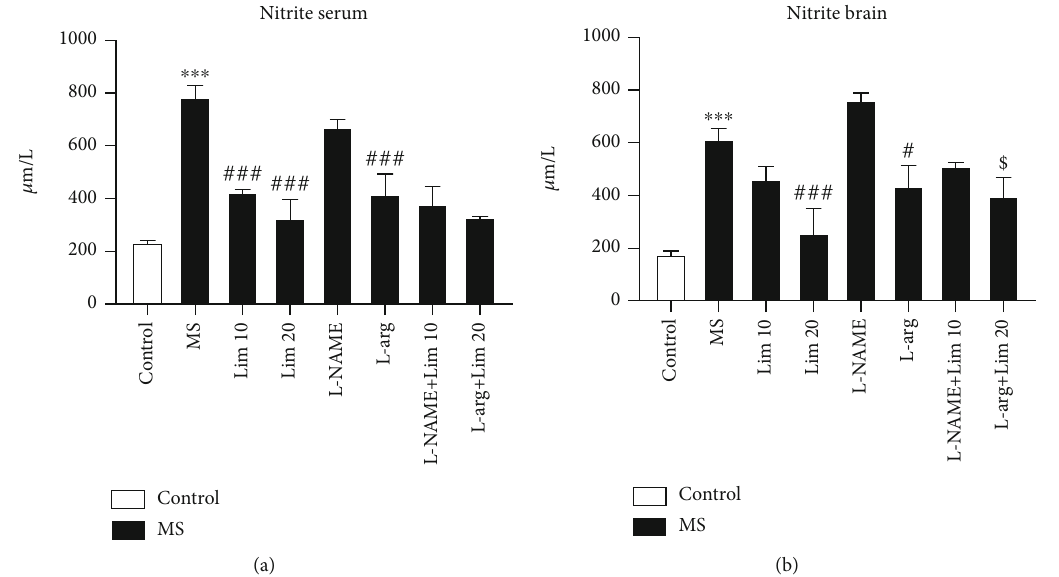
Figure 5: Nitrite levels in the brain and serum samples. Values are presented as the mean ± S : E : M : from 4 samples and were analyzed by one- way ANOVA followed by Tukey ’ s post hoc test. ∗∗∗ P < 0 : 001 compared to the control group. # P < 0 : 05 and ### P < 0 : 001 compared to the MS group. $ P < 0 : 05 compared to the group that received limonene at a dose of 20 mg/kg. MS: maternal separation; Lim: limonene; L-arg: L- arginine.